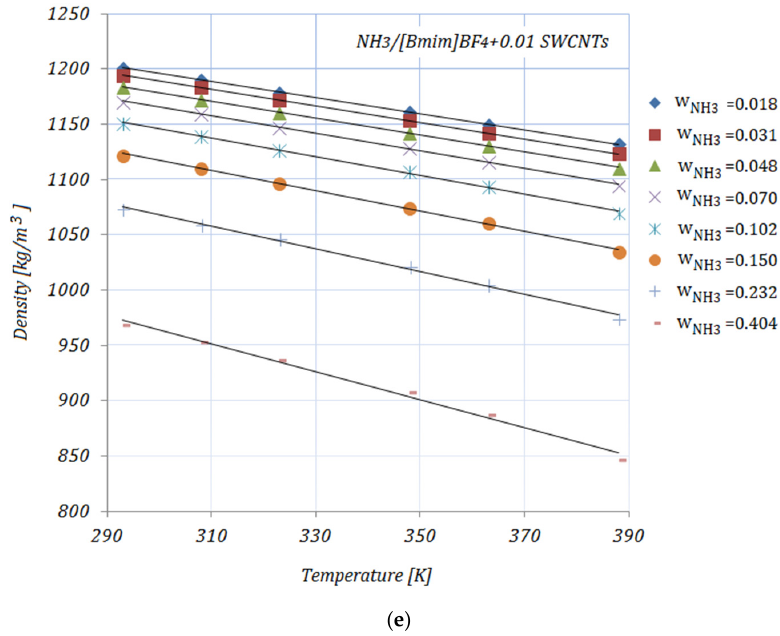
Figure 4. Solution density. Figure 4. – Solution density.